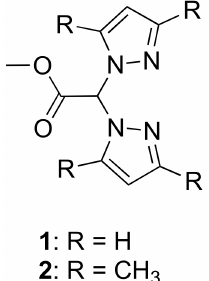
Figure 1. Chemical structures of ligands 1 and 2 .